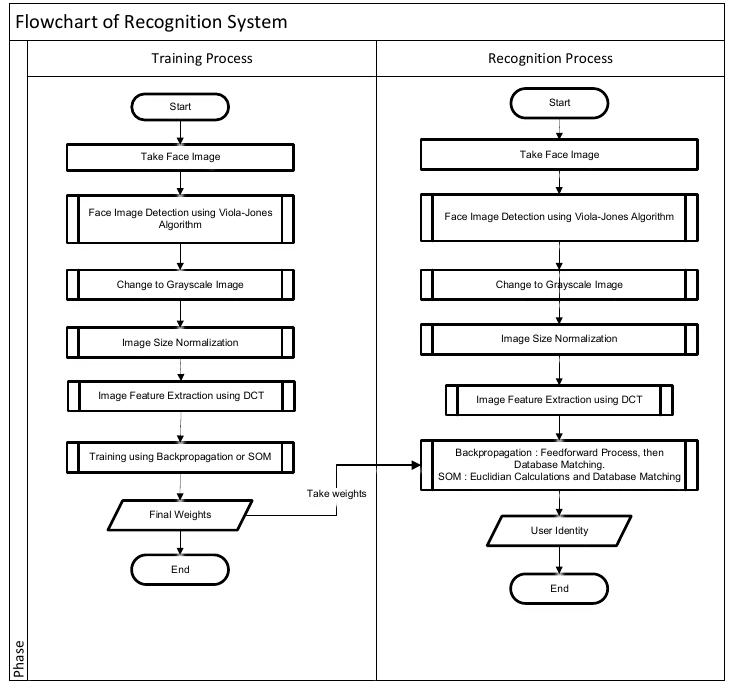
Fig. 3 Flowchart